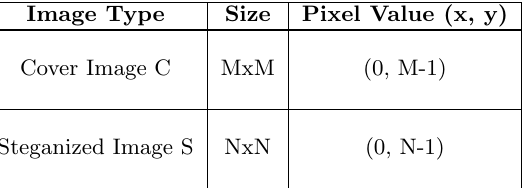
Figure 1: Generating an MMS Stego message using our Android-Stego Framework